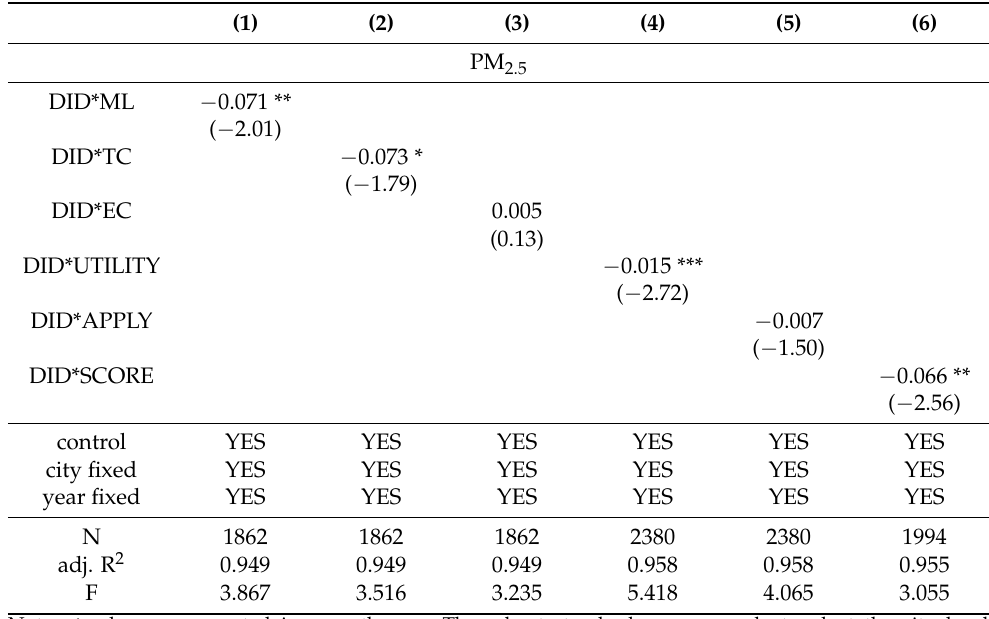
Table 8. Further mechanism